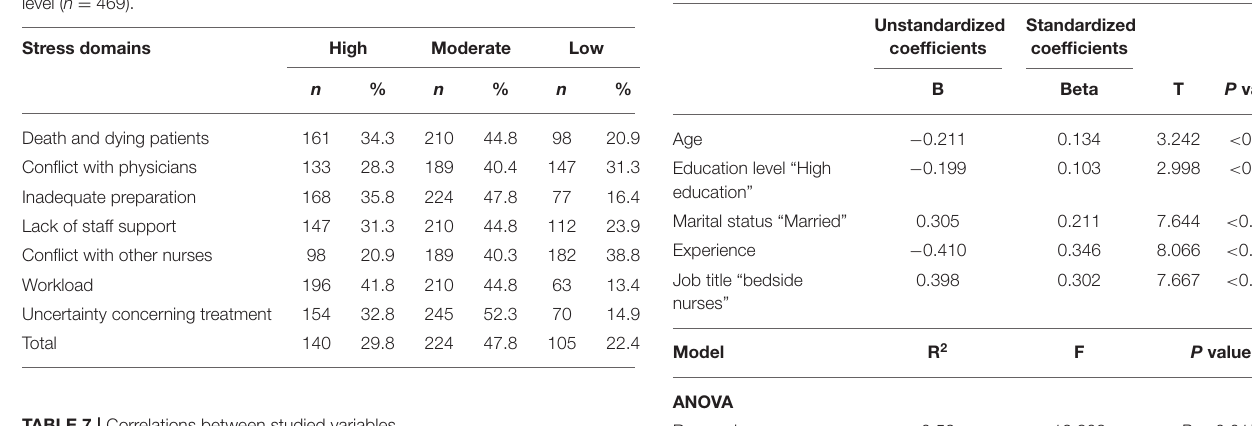
TABLE 9 | MLR models for stress